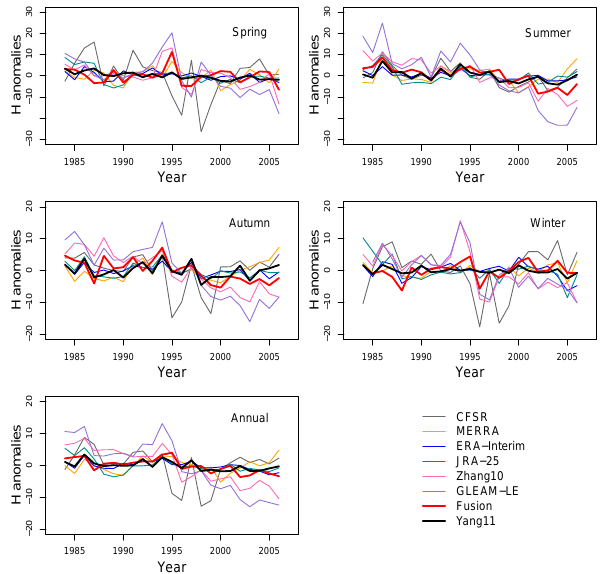
Figure 4. Anomalies of sensible heat flux from multiple data sets and fused data with ground measurement averaged for all available CMA stations (units are Wm − 2